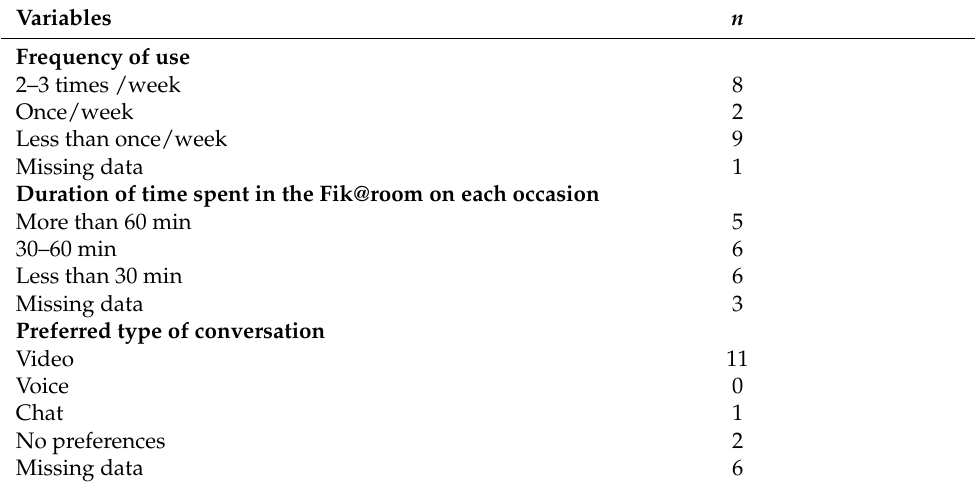
Table 4. Older adults’ patterns of use at posttest ( n =